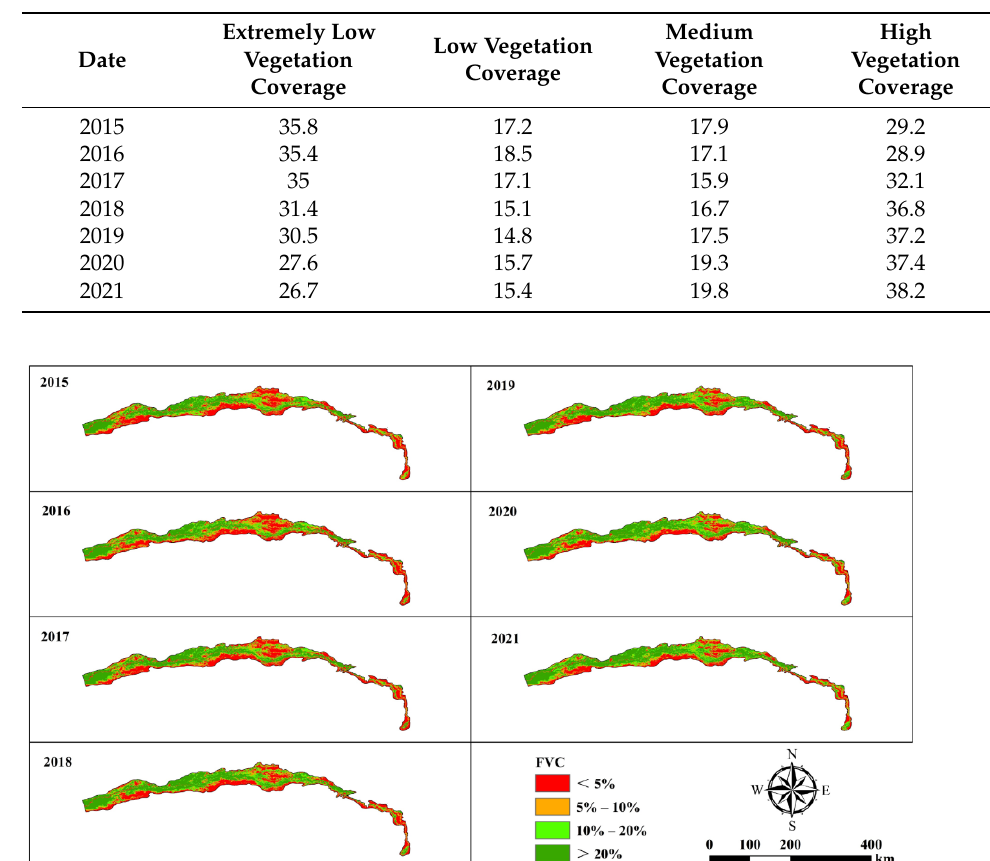
Table 4. Monitoring statistics of vegetation coverage in the mainstream area of the Tarim River from 2015 to 2021 (Unit: %).